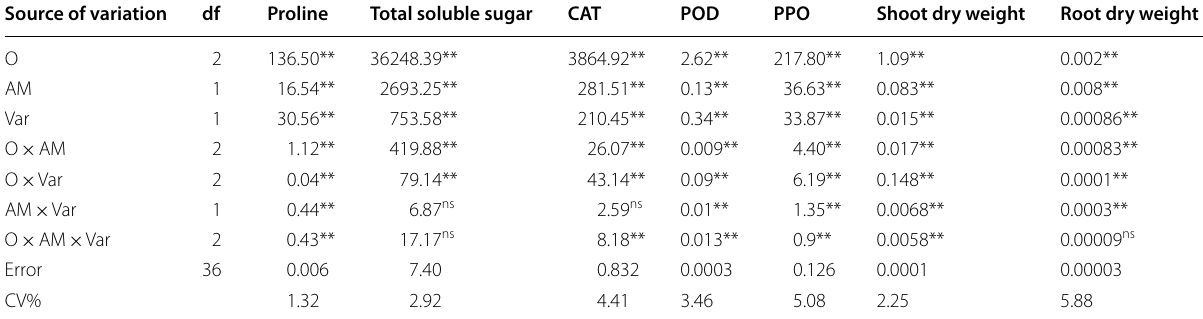
O: Osmotic stress , Var: Varieties, AM: Arbuscular mycorrhizal inoculation, ns: non-significance at P